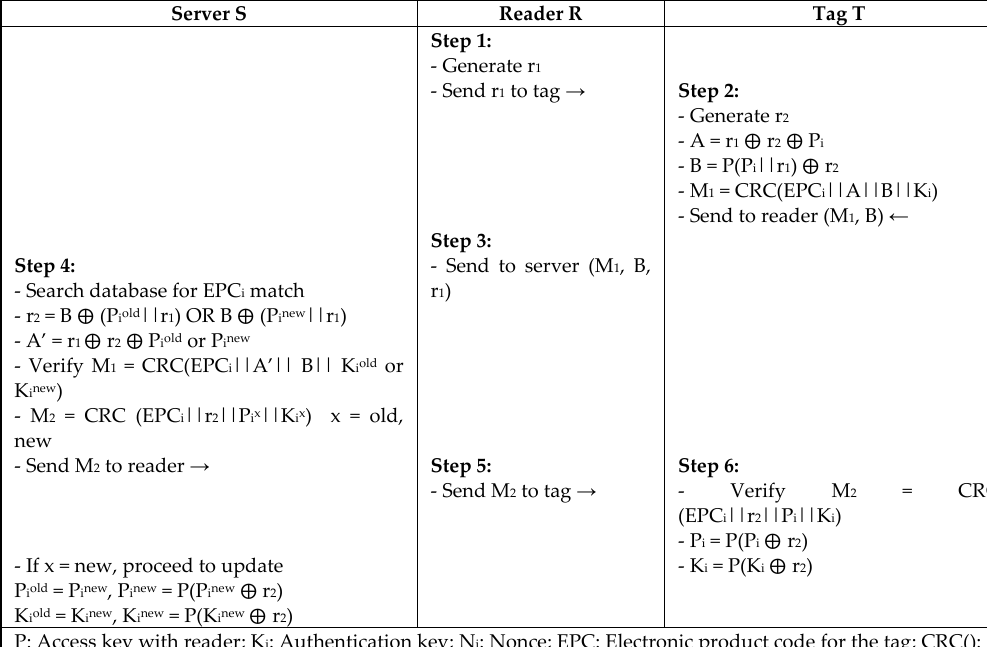
Figure 26. Mutual Authentication Protocol (MACD) by Huang and Jiang.